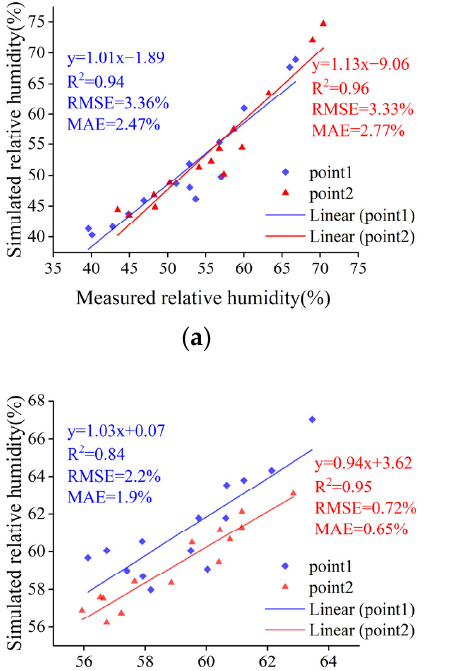
Figure 7. Relationship between the simulation and measurement of air temperature. ( a ) Points 1 and 2 in summer, ( b ) points 3 and 4 in summer, ( c ) points 1 and 2 in winter, and ( d ) points 3 and 4 in winter.